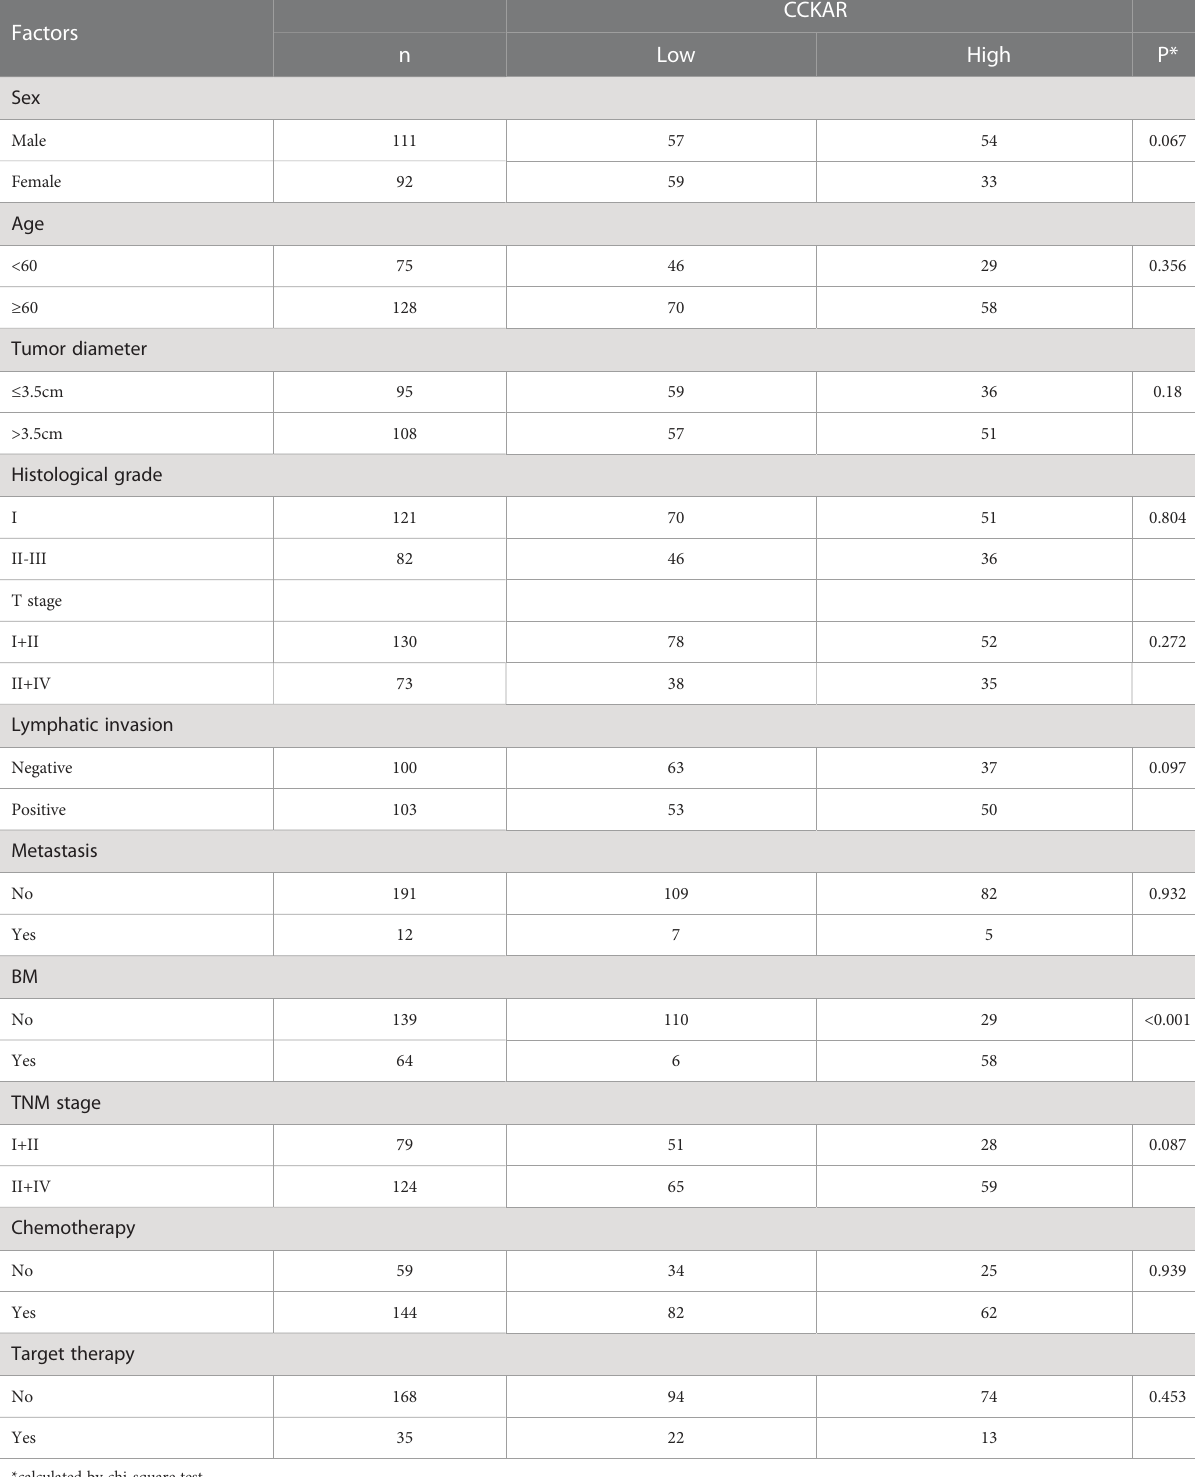
TABLE 1 The correlation between CCKAR expression and clinicopathological factors in